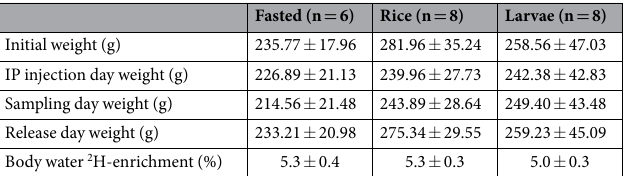
Table 2. Body mass (g) and body water 2 H-enrichment (%) from black-tailed godwits submitted to three different conditions in captivity (Fasted, Rice and Larvae). Mean values ± SEM are presented. No significant differences between dietary treatments (one-way ANOVA followed by Tukey’s test).